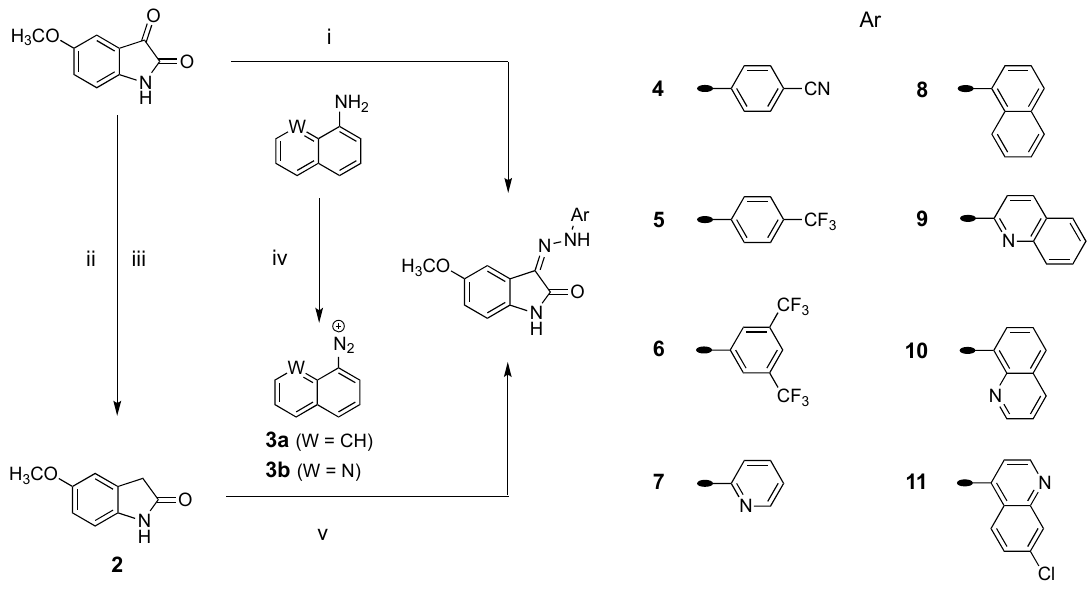
Figure 2. Summary of the investigated structural modifications of isatin-3-arylhydrazones.